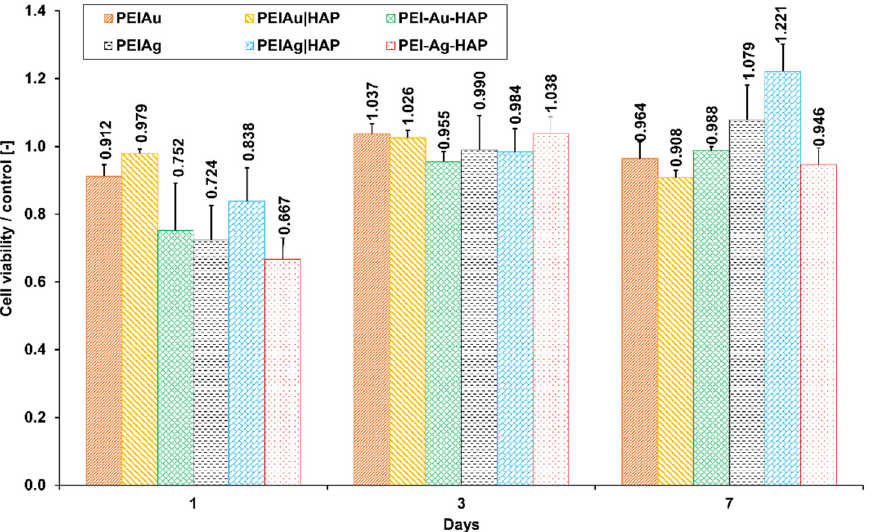
Figure 11. The ratio of the percentage of viable human dermal fibroblasts immobilized within membranes to the control during 7-day culture. Key to the symbols: polyethyleneimine membrane with AgNPs (PEI-Ag), bilayer consisting of polyethyleneimine with incorporated AgNPs and hydroxyapatite (PEI-Ag|HAP); polyethyleneimine with AgNPs and HAP complex (PEI-Ag-HAP); polyethyleneimine with AuNPs (PEI-Au); bilayer consisting of polyethyleneimine with incorporated AuNPs and hydroxyapatite (PEI-Au|HAP); polyethyleneimine with AuNPs and HAP complex (PEI-Au-HAP). The values are presented as mean ± SD.